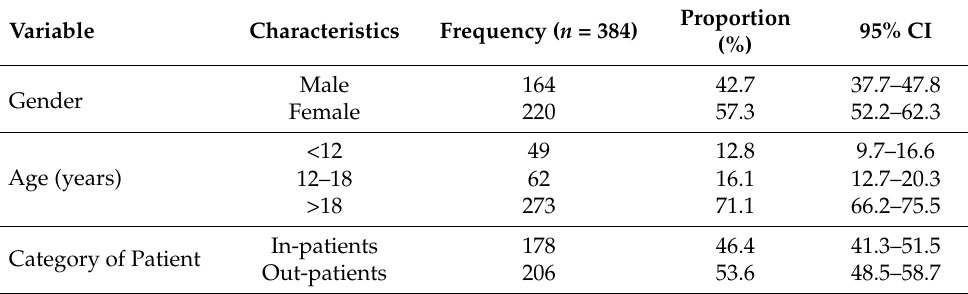
Table 1. Sociodemographic characteristics of patients based on the reviewed medical files.